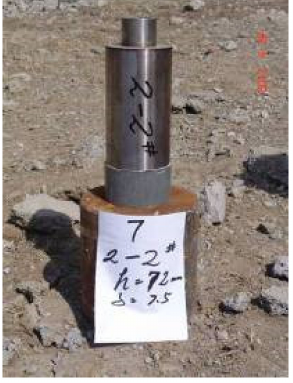
Figure 5. Arrangement of experimental